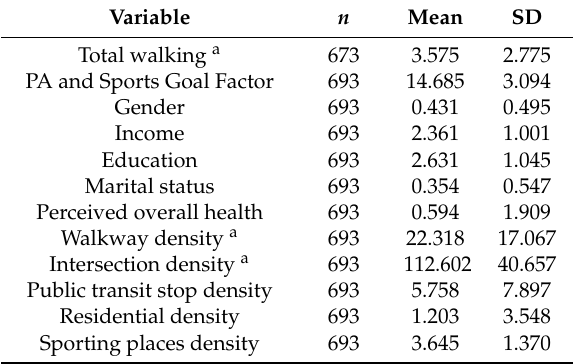
Table 3. The descriptive statistics of the variables used in the